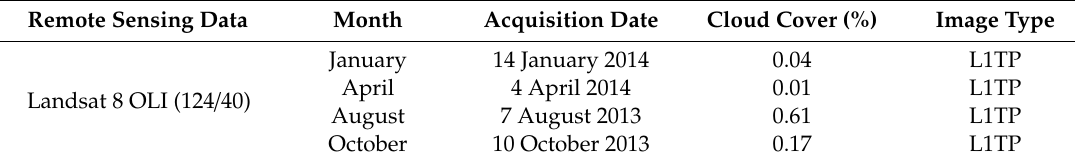
Table 2. Landsat 8 Operational Land Imager (OLI) imagery acquired for this study.